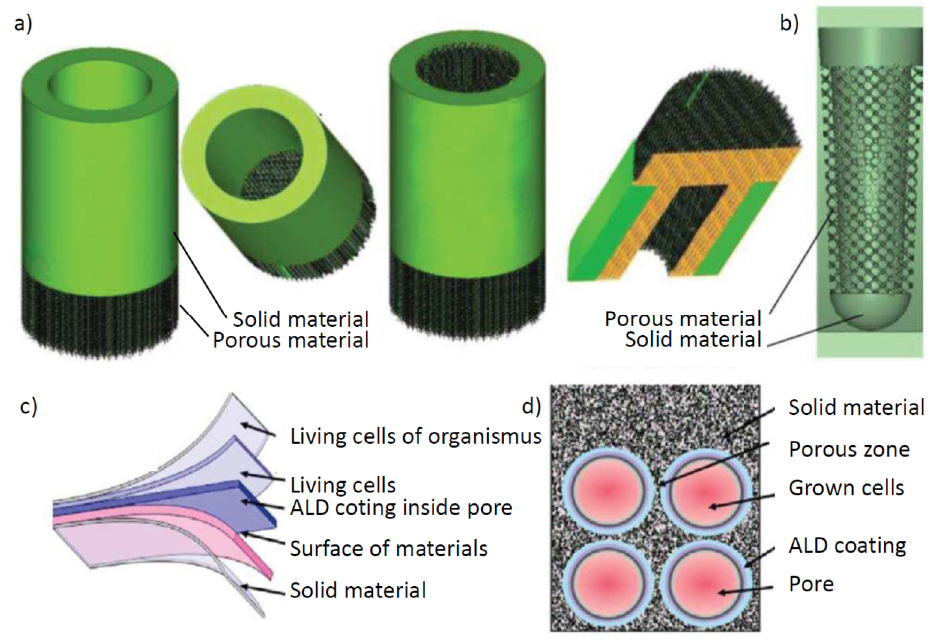
Figure 5. Scheme of composite biological-engineering; ( a ) orthopedically implant-scaffolds; ( b ) dental implant-scaffold; ( c ) the concept of multilayer engineering-biological layers inside the pores; ( d ) the structure of solid-porous engineering-biological materials.